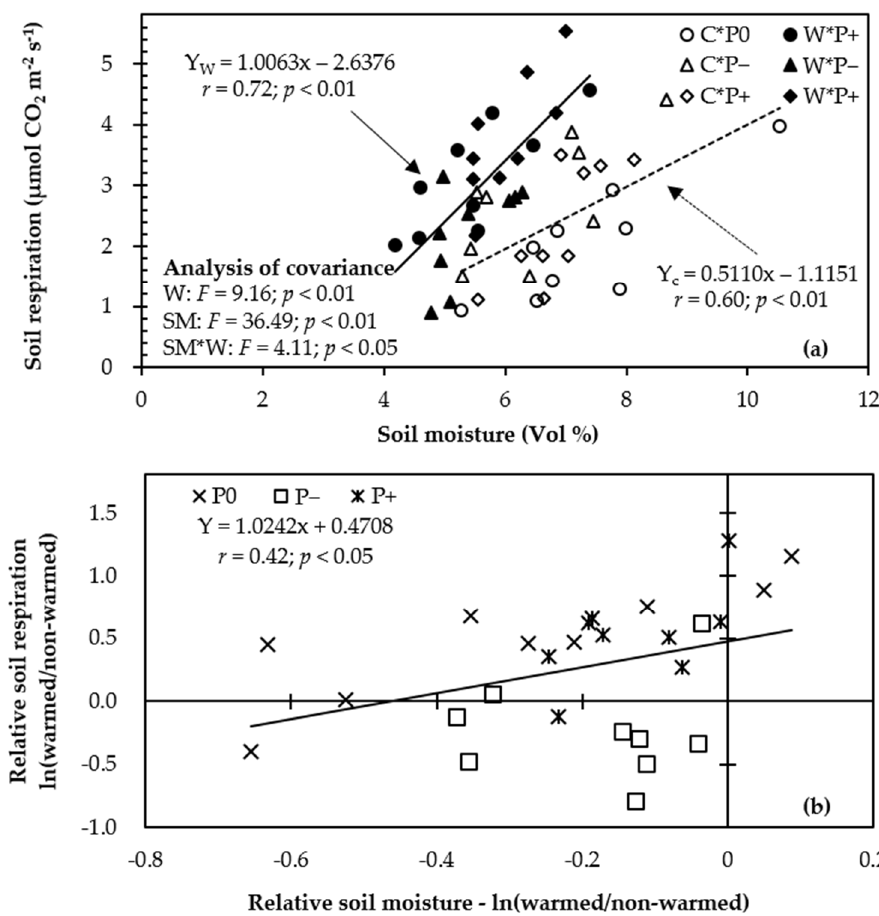
Figure 3. ( a ) Soil respiration plotted against soil moisture in warmed plots (YW) and non ‐ warmed plots (YC); ( b ) relative soil respiration between warmed and non ‐ warmed plots plotted against relative soil moisture between the warmed plots and non ‐ warmed plots. Treatments: P0 = precipitation control; P − = reduced precipitation; P+ = elevated precipitation; C*P0 = atmospheric temperature control and precipitation control; W*P0 = atmospheric warming and precipitation control; C*P − = atmospheric temperature control and reduced precipitation; W*P − = atmospheric warming and reduced precipitation; C*P+ = atmospheric temperature control and elevated precipitation; and W*P+ = atmospheric warming and elevated precipitation.